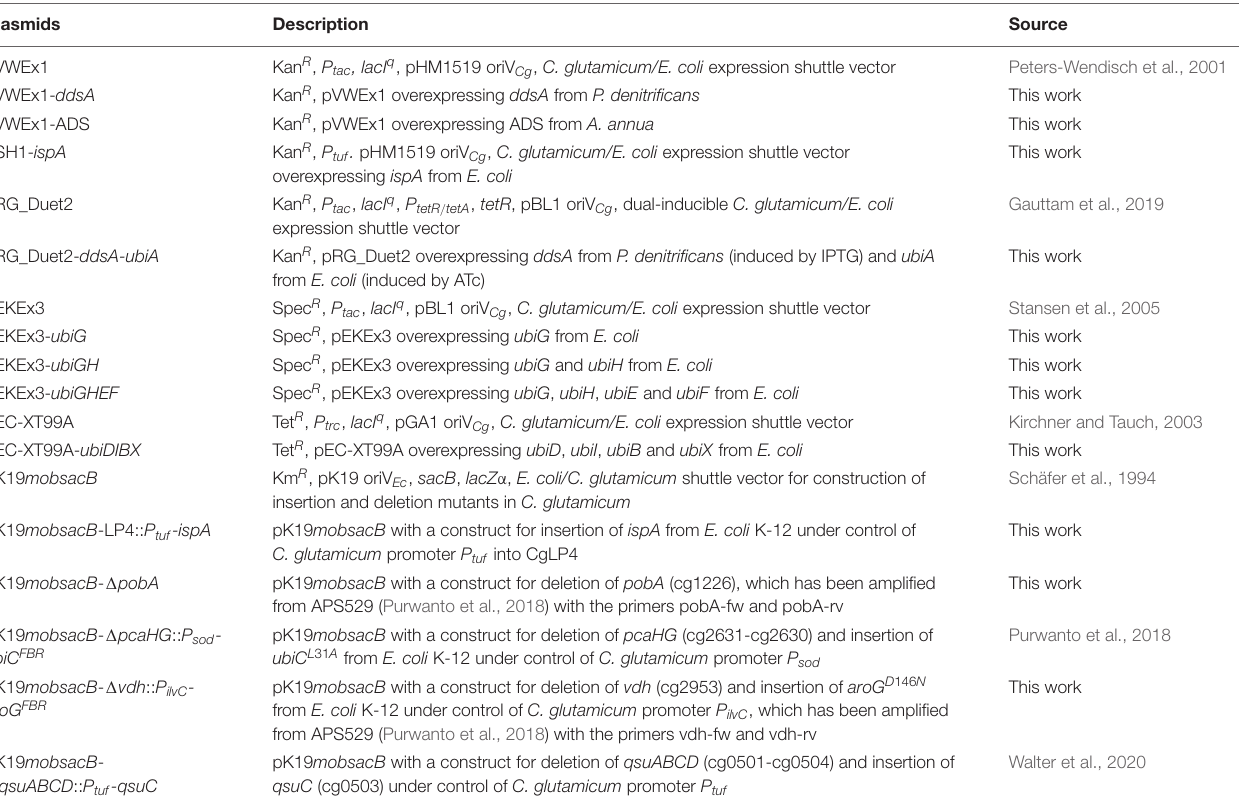
TABLE 2 | Plasmids used in this